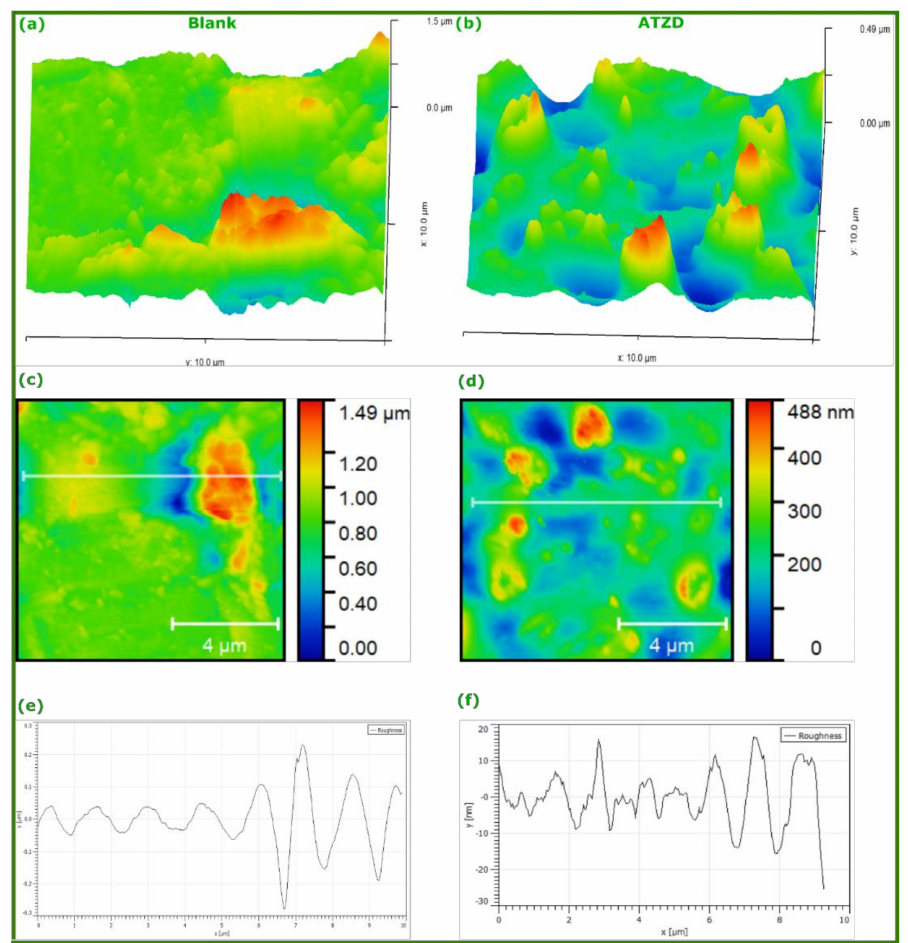
Figure 6. AFM results of copper in 3.5 wt.% NaCl without and with 150 ppm of ATZD at 298 K; ( a , b ): 3D, ( c , d ): 2D, and ( e , f ): Roughness of selected